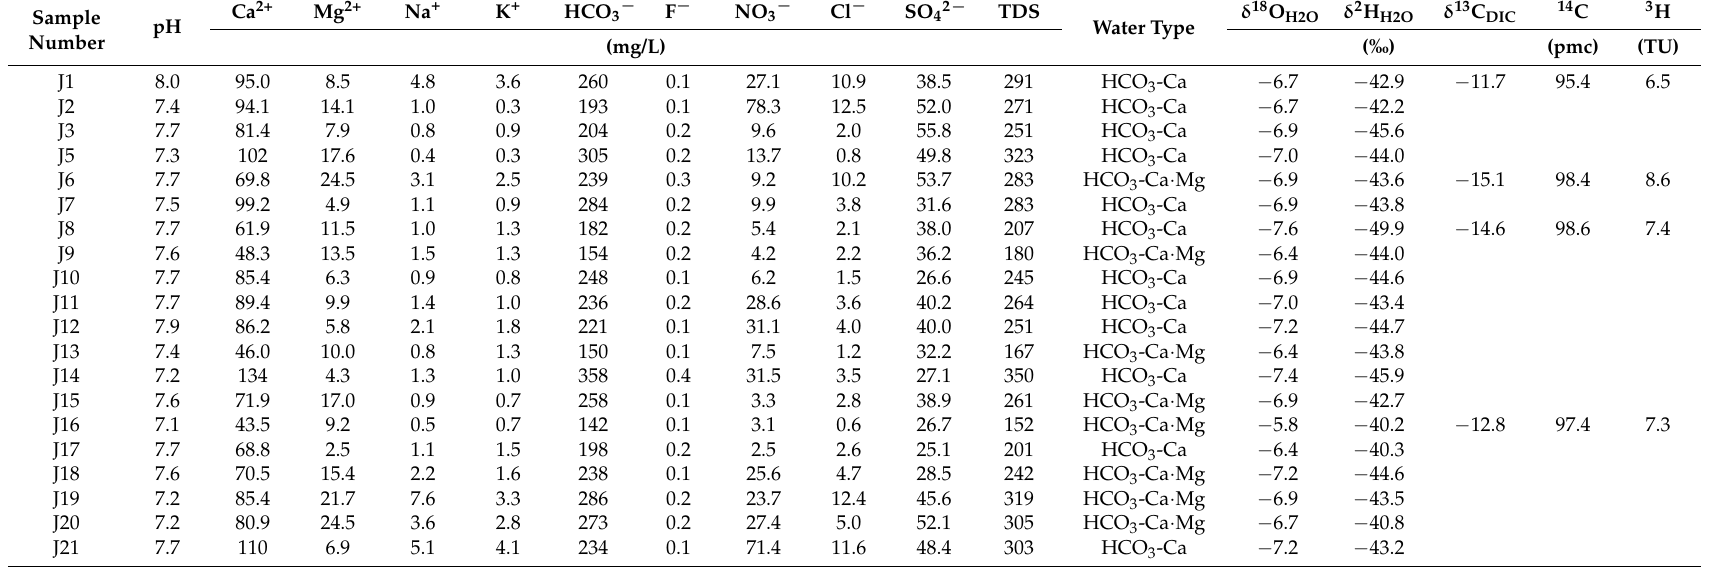
Table 1. Geochemical and isotopic compositions of shallow groundwater in the JSB